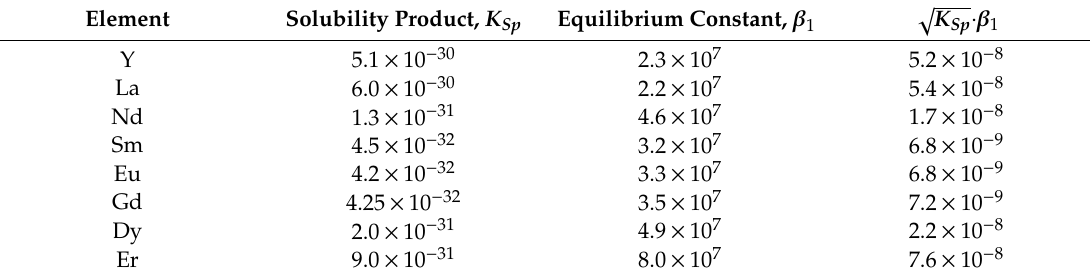
Table 4. Solubility products [14], equilibrium constants [14] and their products